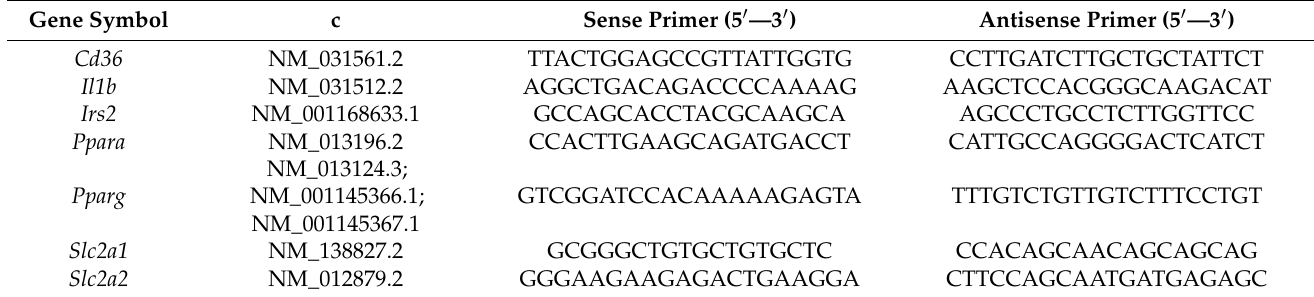
Table 1. Sequences of oligonucleotides used as primers in qPCR